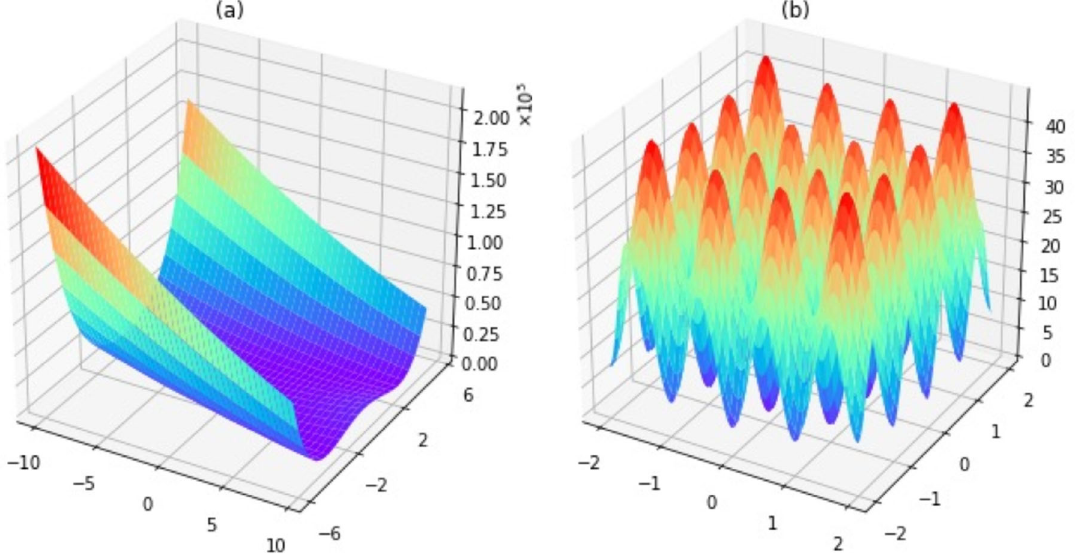
Fig. 1 Plots of black-box functions. a The valley of a two-dimensional Rosenbrock function which has the formula y ¼ 100 ð x 2 (cid:2) x 2 b The frequent and regularly distributed local minima of a two-dimensional Rastrigin function which has the